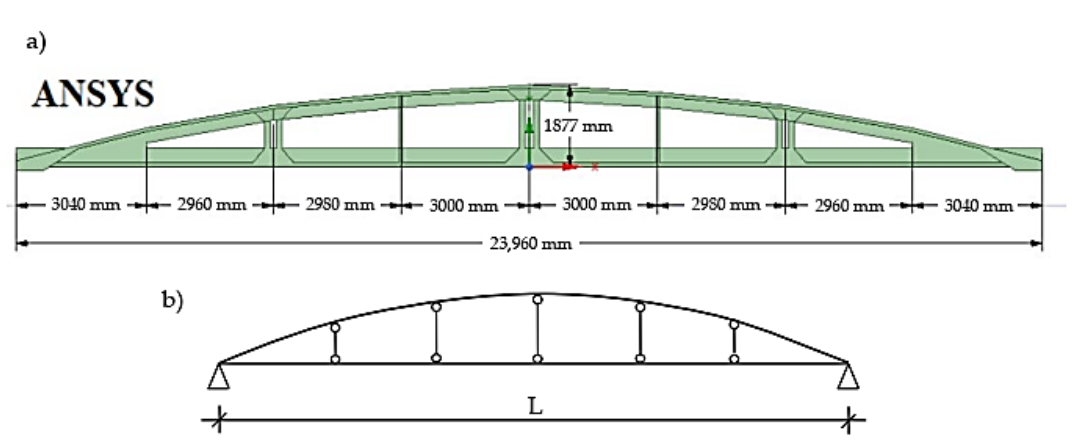
Figure 3. Calculation models of posttensioned concrete girder KBOS-24: ( a ) Geometry of model prepared in Ansys; ( b ) Equivalent simplified model.